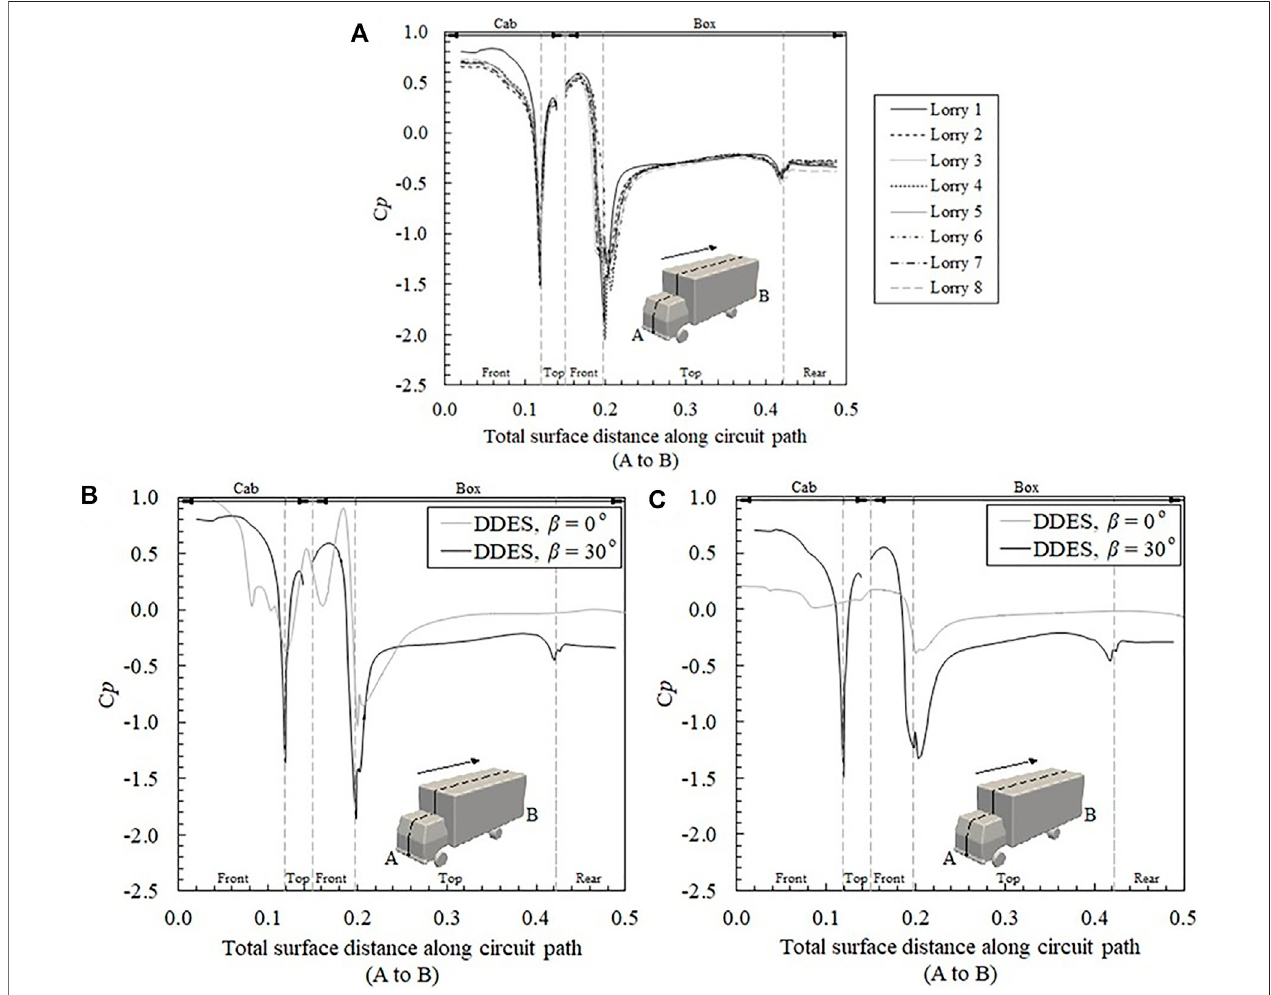
FIGURE 9 | (A) Comparison of the distribution of pressure coef fi cient along the surface distance from the circuit path (A,B) on all lorries. Comparison between the crosswind and no-crosswind cases of the C p distribution along the surface distance from the circuit path (A,B) on (B) . lorry one and (C) . lorry 5.